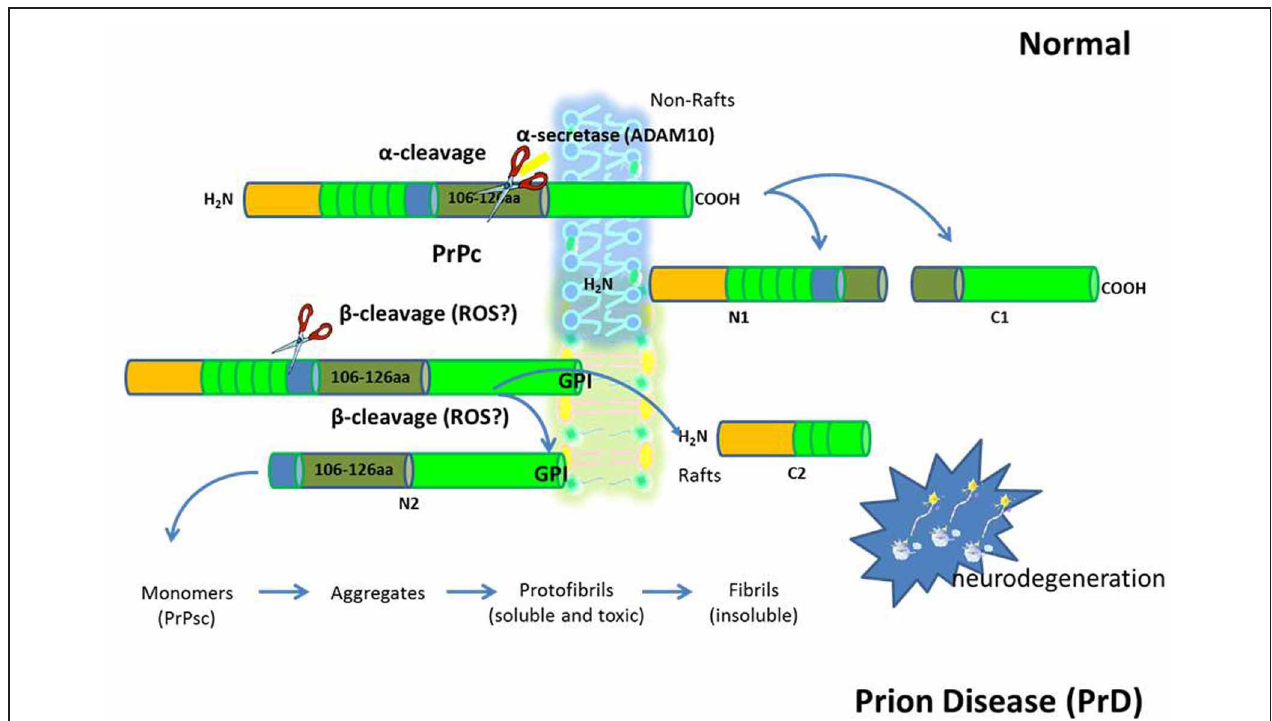
composed mainly or entirely of an abnormal conformation of a host-encoded glycoprotein called the prion protein (PrPc). The replication of prions implies the transformation of the normal version of this protein PrPc into a misfolded form (PrPsc). An increased concentration of PrPc at the membrane leads to a structural transition toward abnormal intermolecular beta sheet. This dimerization could well be the initial step on the pathway of the conversion into